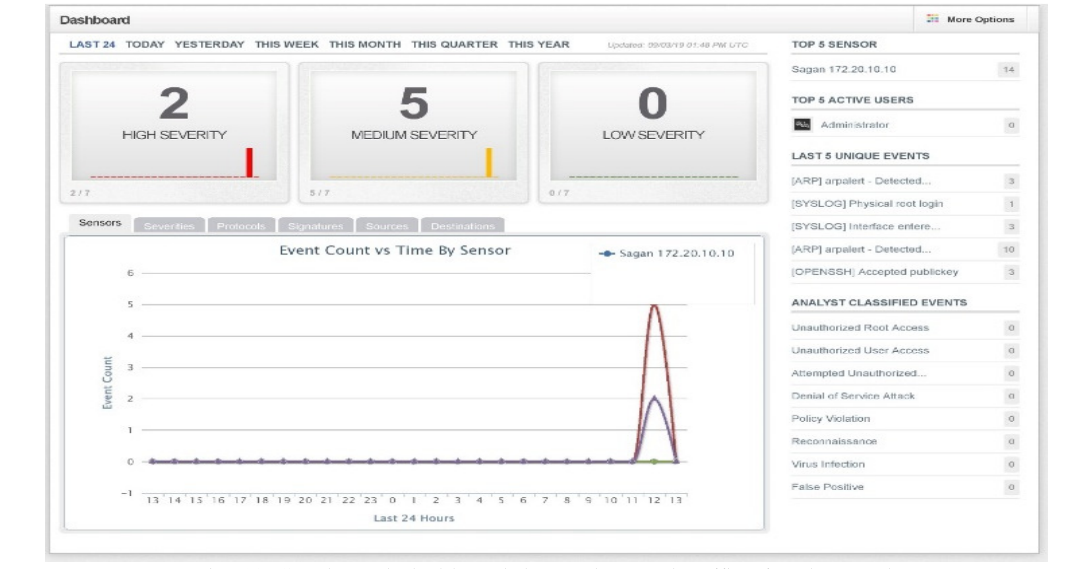
Fig. 18: Snorby web dashboard shows abnormal traffic after the